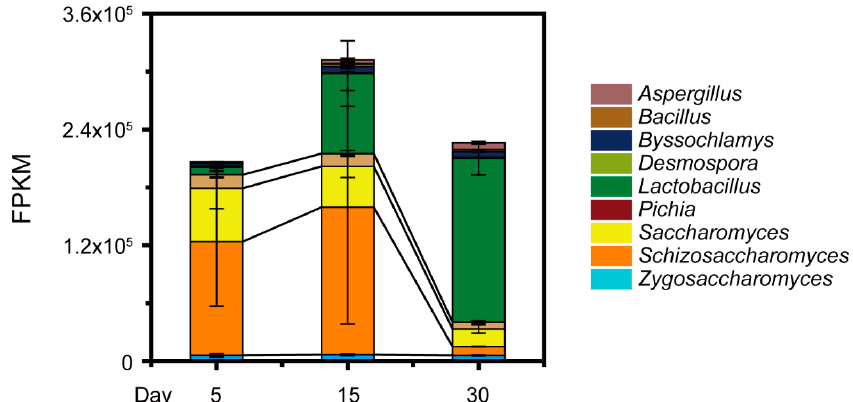
Figure 3. The gene expression of nine dominant fungal and bacterial genera (i.e., abundance >1%) by metatranscriptomic analysis on day 5, 15, and 30 during Baijiu production. The nine dominant genera are Aspergillus , Bacillus , Byssochlamys , Desmospora , Lactobacillus , Pichia , Saccharomyces , Schizosaccharomyces, and Zygosaccharomyces . Data are expressed as mean ± SD from biological triplicates. Error bars indicate standard deviation from three independent sampling